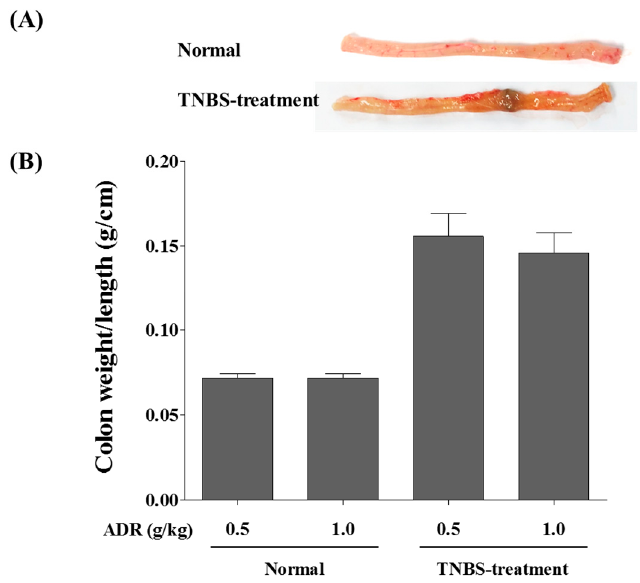
Figure 3. TNBS-induced experimental colitis in rats. ( A ) Macroscopic appearance of normal and damaged colon; ( B ) Weight of explanted colon.